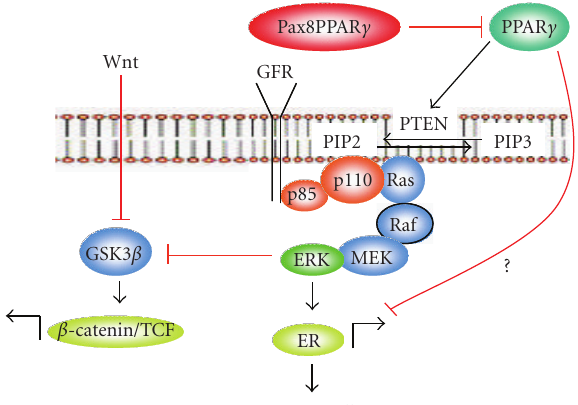
Figure 1: Pax8PPAR γ and mammary cell fate